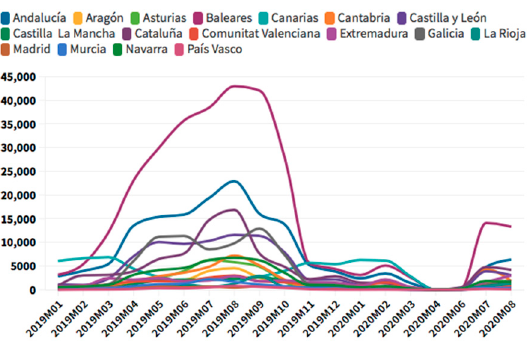
Figure 7. International tourism rural accommodation occupancy. Source: Own elaboration from INE data.